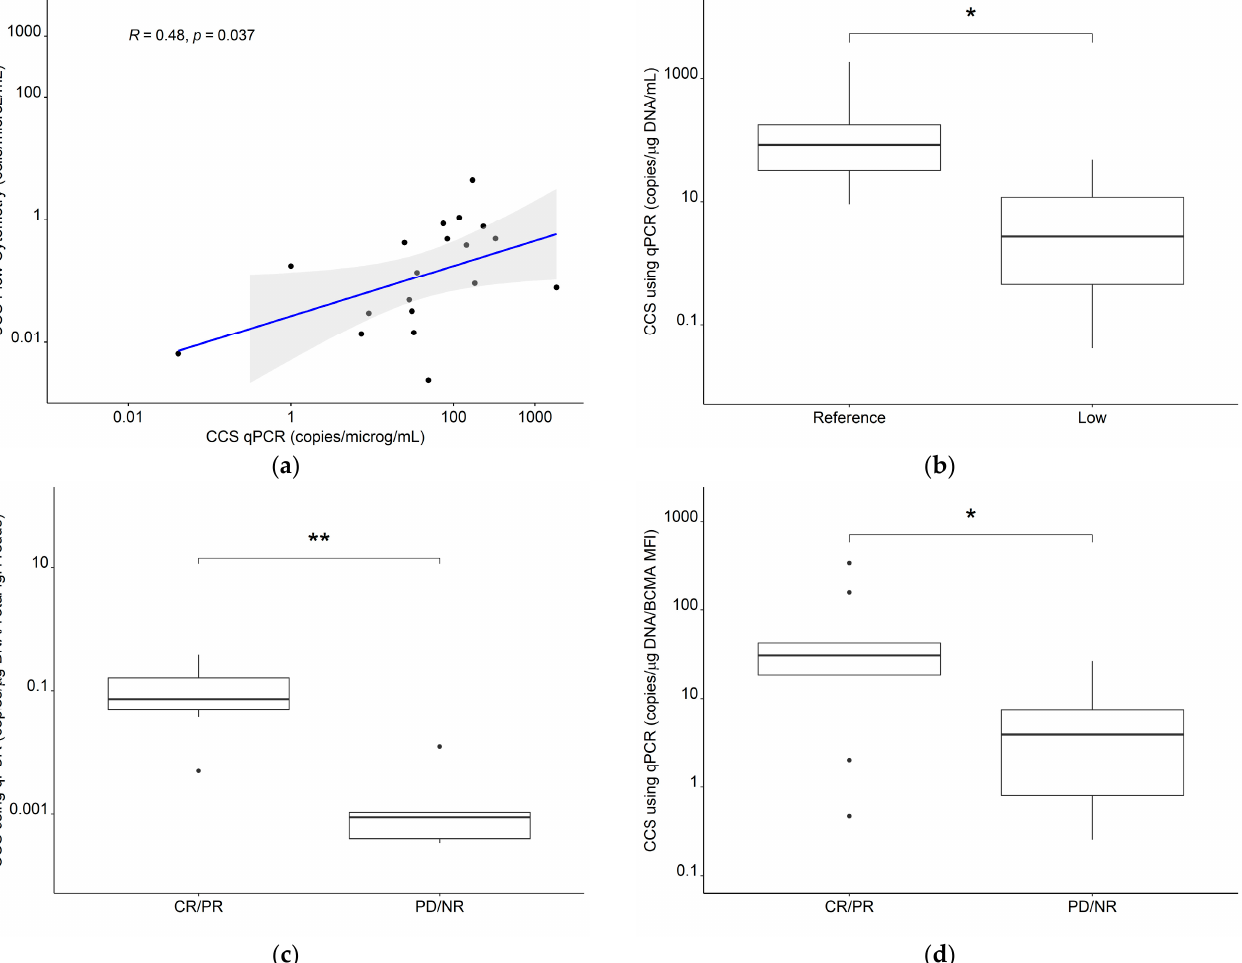
Figure 10 Figure 10. ( a ) Correlation for the clinical composite score for T all using flow cytometry or qPCR and comparisons of the CCS using qPCR between ( b ) reference expansion population and low expansion subpopulation in our clinical dataset, ( c ) CR/PR and PD/NR in CLL patients ( n = 12) and ( d ) CR/PR and PD/NR in MM patients ( n = 19). Abbreviations—CLL: chronic lymphocytic leukemia; CR: complete response; MM: multiple myeloma; NR: no response; PR: partial response; qPCR: quantitative polymerase chain reaction; T all : the sum of all measured CAR-T cell phenotypes. *: p ≤ 0.05, **: p ≤